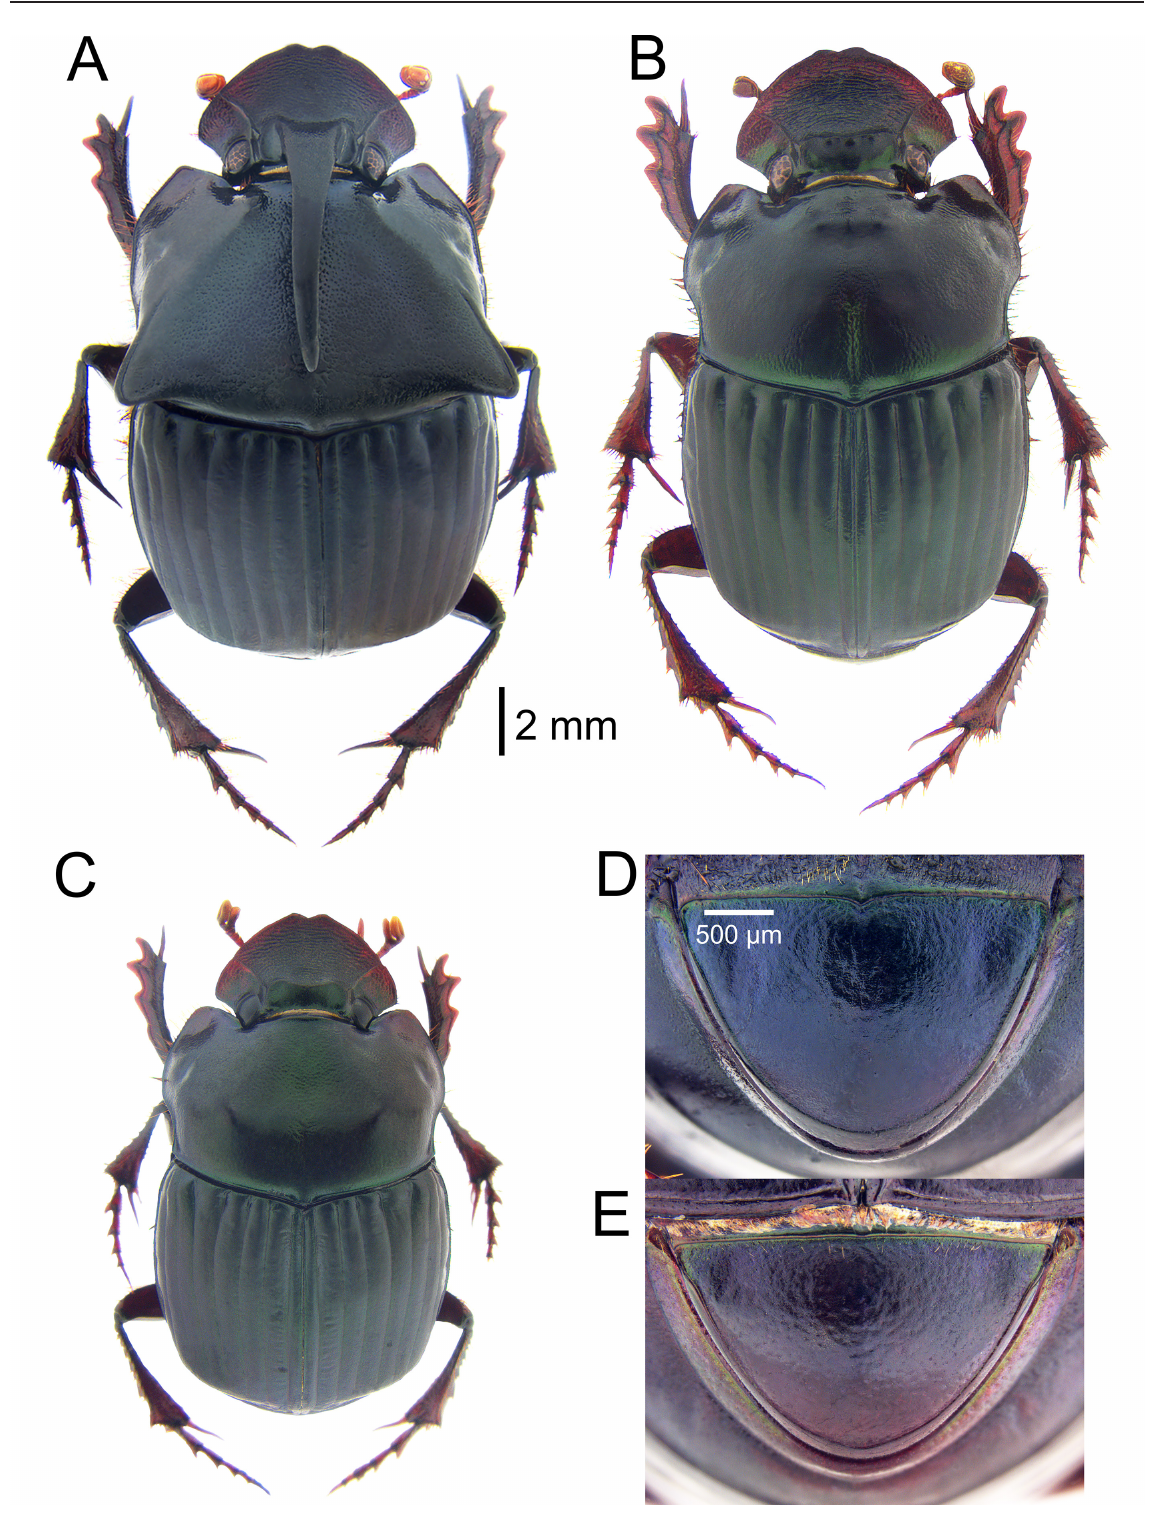
Fig. 14. A–D . Phanaeus zapotecus Edmonds, 2006. A . ♂ (TAMU). B . ♀ (TAMU). C . Minor ♂ (VMC). D . Tergite VIII (TAMU). E . Phanaeus dionysius Kohlmann, Arriaga-Jiménez & Rös, 2018 syn.